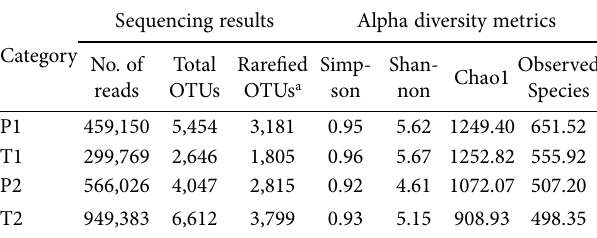
Table 2. Sequencing and alpha diversity results from analyses of DNA extracted from wheat sap extracted from four wheat variety and field categories: P1 = Perciasacchi from Field 1; T1 = Tum- minia from Field 1; P2 = Perciasacchi from Field 2; and T2 = Tum- minia from Field